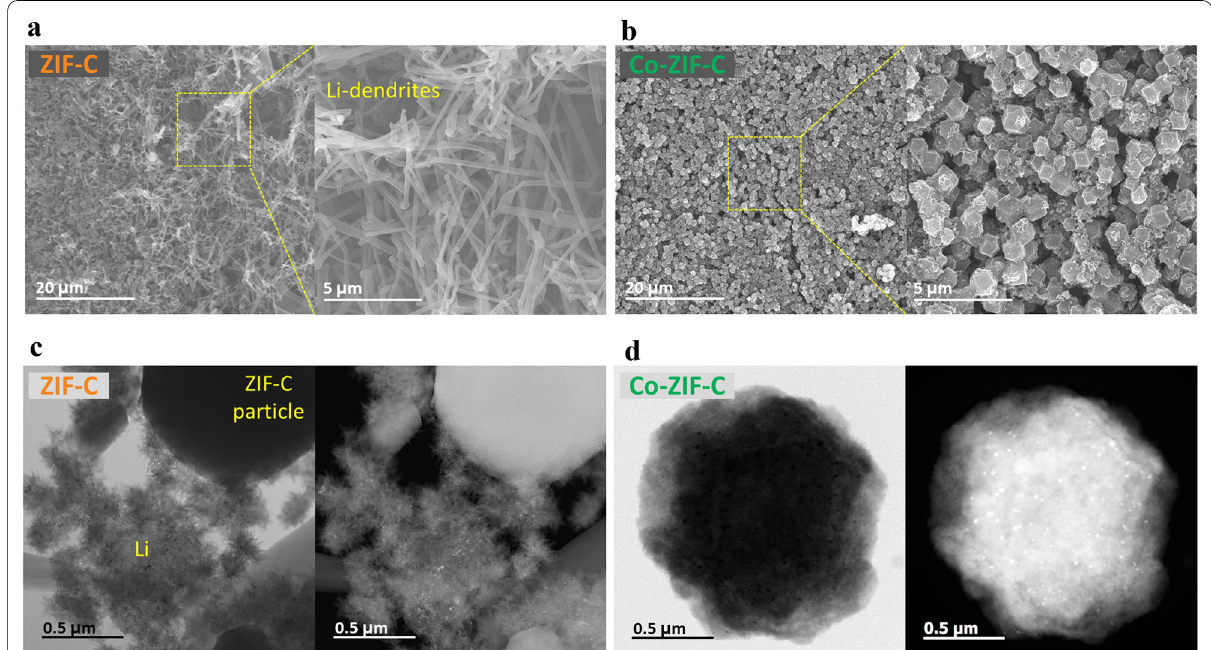
Fig. 3 FESEM top‑view observations of Li‑plated ( a ) ZIF‑C and ( b ) Co‑ZIF‑C electrodes; TEM observations of Li‑plated ( c ) ZIF‑C and ( d ) Co‑ZIF‑C